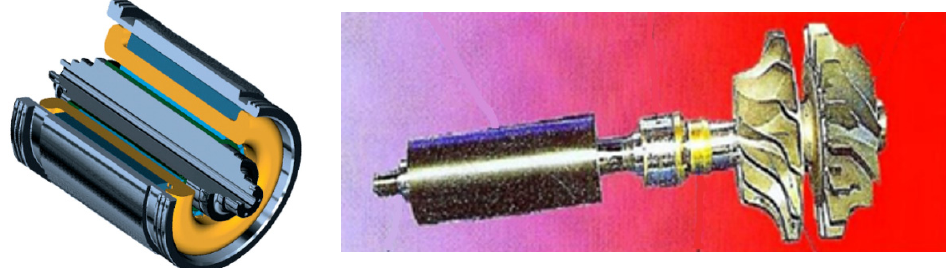
Figure 1. The design of a high-speed gearless radial generator and its components. Figure 2 shows the power unit of a gas turbine unit with a built-in radial generator.